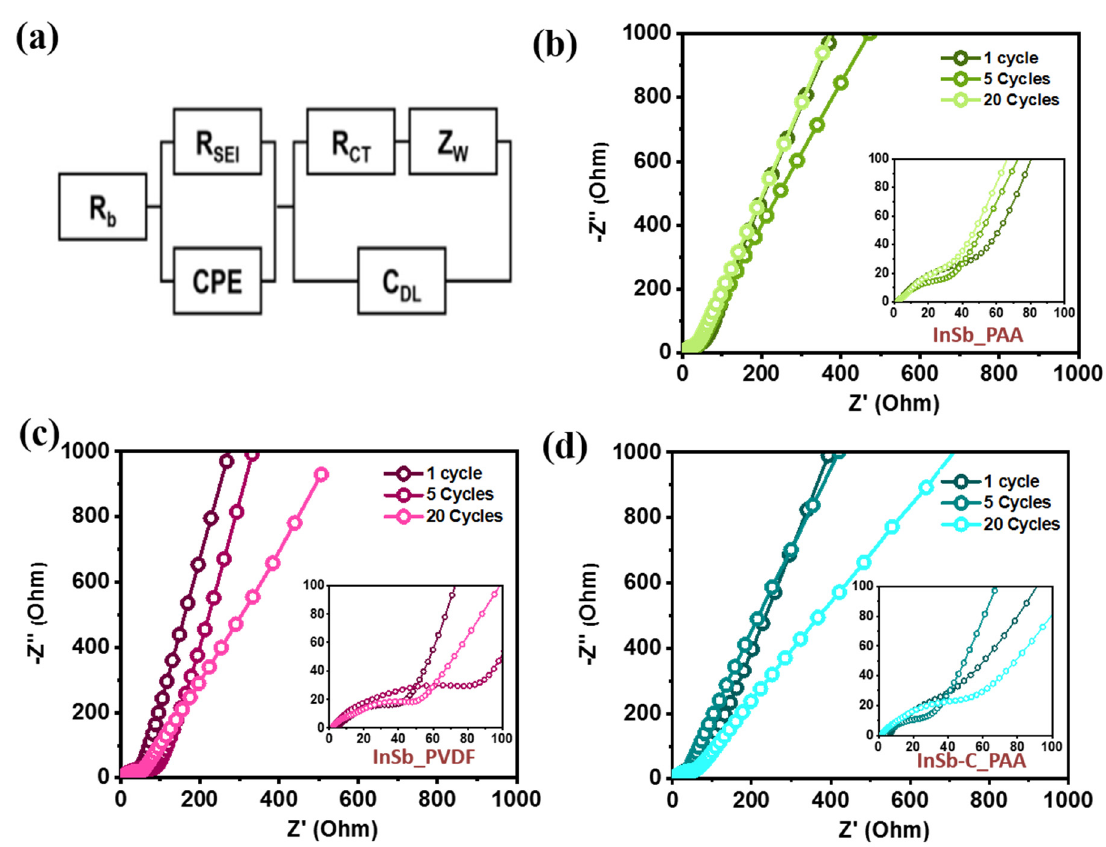
Figure 7. ( a ) The equivalent circuit. Nyquist plots after 1, 5, and 20 cycles for ( b ) InSb_PAA, ( c ) InSb_PVDF, and ( d ) InSb–C_PAA.